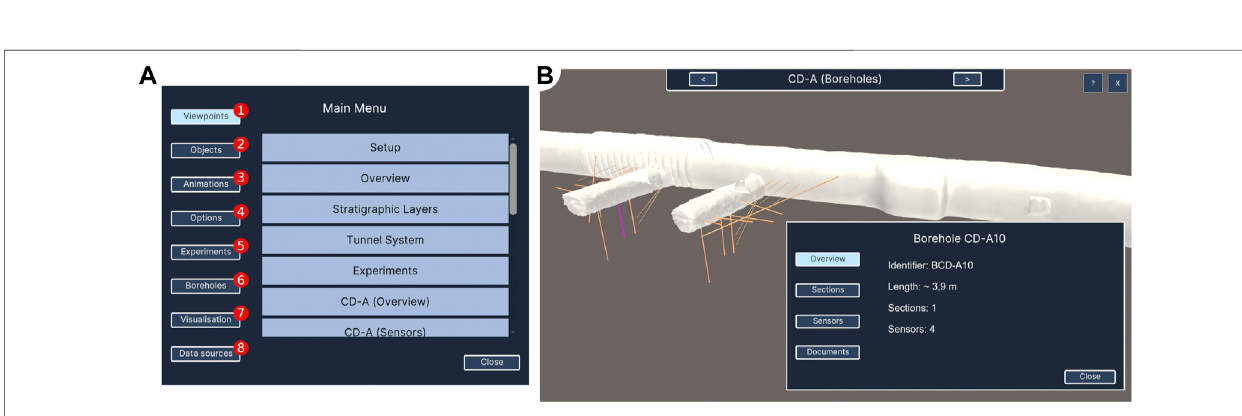
Frontiers in Earth Science |